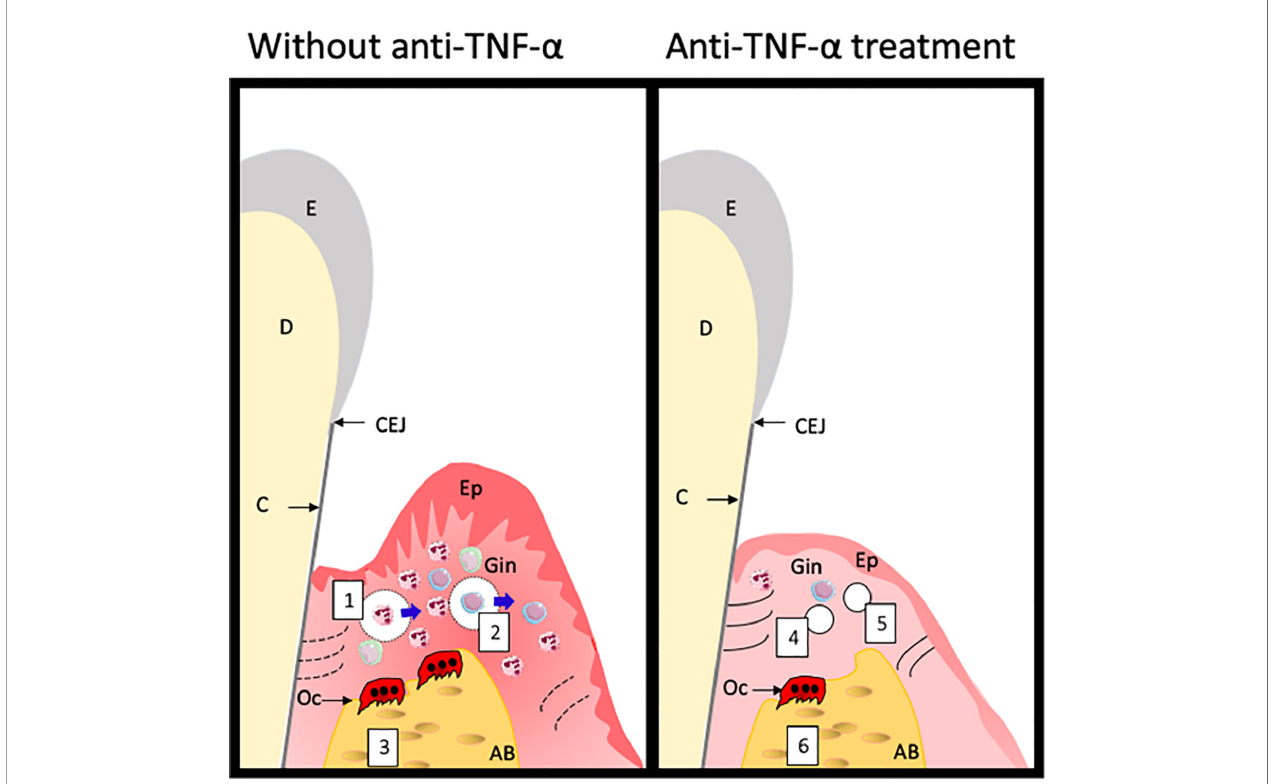
FIGURE 3 | Hypothetical changes of the periodontium following anti-TNF treatment. Treatment with anti-TNF- a leads to overcoming the TNF- a associated cellular processes such as vasodilatation and permeability for leukocytes (1), proteolysis by this excess of leukocytes of extracellular matrix components, depicted as dotted lines (2) and activation of osteoclasts (3). Anti-TNF- a treatment may lead to less dilated and less permeable blood vessels (4), less proteolytic activity, restoring the extracellular matrix production (5) and tempering osteoclast formation and activity. Clinically, this all leads to less bleeding on probing, and an improvement in attachment which is observed by a decreased PPD and CAL. E, Enamel; CEJ, cemento-enamel-junction; C, cementum; D, dentin; Ep, epithelium; Gin, Gingiva; Oc, osteoclast; AB, alveolar